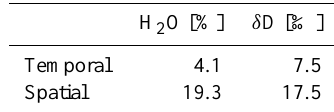
The IASI water vapour isotopologue products are rather complex and we can offer two different product types. The same classification has been used for the MUSICA NDACC 480 / FTIR dataset as presented in Schneider et al. (2012). Type 1 is a water vapour profile product given by the direct retrieval output ˆ x . It is characterised by a good vertical resolution (the respective kernels are depicted in the top left graph in Fig. 2). Type 2 is a product for water vapour isotopologue 485 research and it is calculated from the retrieval output by the aposteriori processing as described in Eq. 6. For type 2 the water vapour profile has reduced vertical resolution, but it is representative for the same altitudes as the retrieved δ D (the kernels are presented in the top left and bottom right graph 490 in Fig. 4). Furthermore, for type 2 the retrieved δ D values are less dependent on atmospheric humidity if compared to retrieved type 1 δ D values.